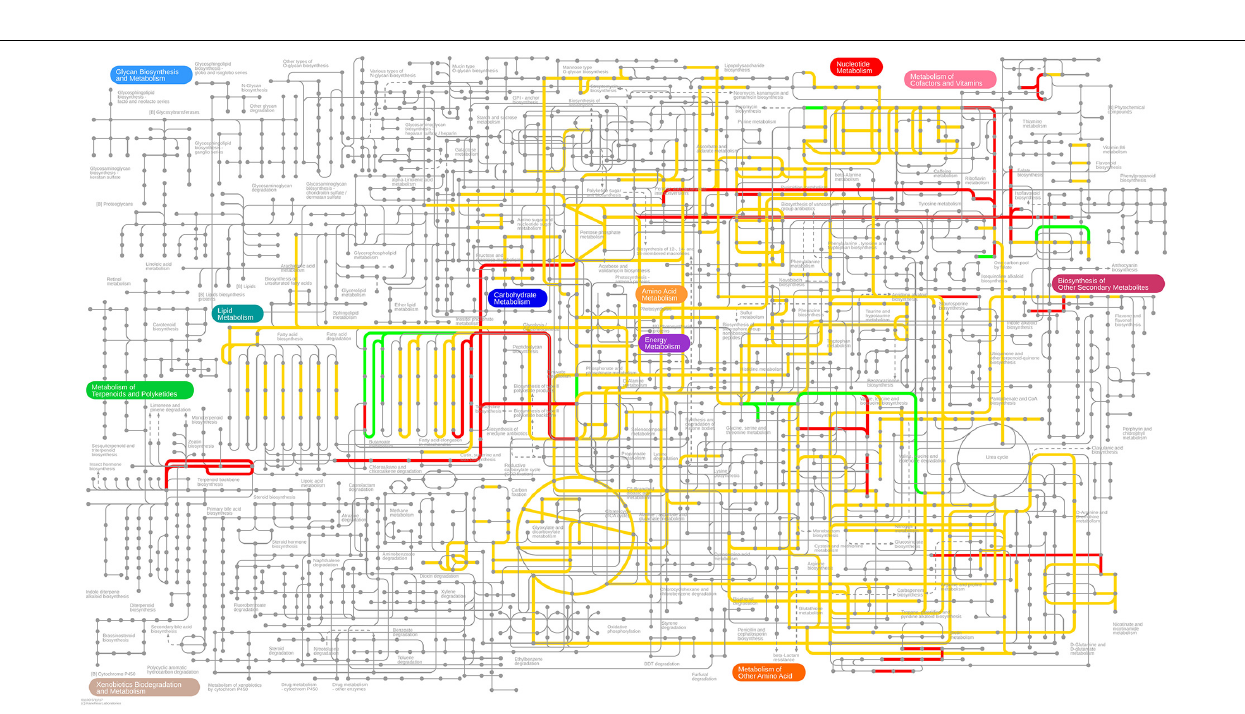
FIGURE 8 | Predicted up- and down-regulated fluxes in response to Pd stress using the i ML1515 genome-scale metabolic model, presented for the KEGG pathway map of E. coli . Up-regulated fluxes are green, down regulated fluxes red, and fluxes without a regulation requirement are colored yellow. No-flux reactions and reactions without KEGG IDs are